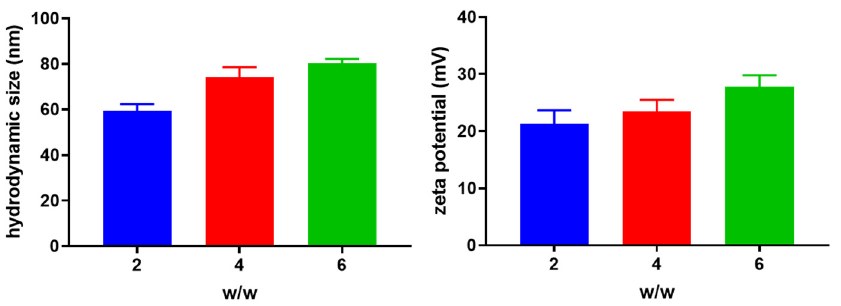
Figure 2. Characterization of Chol-PCX/miRNA nanoparticles. Hydrodynamic size and zeta poten- tial of nanoparticles prepared at different Chol-PCX/miRNA w/w